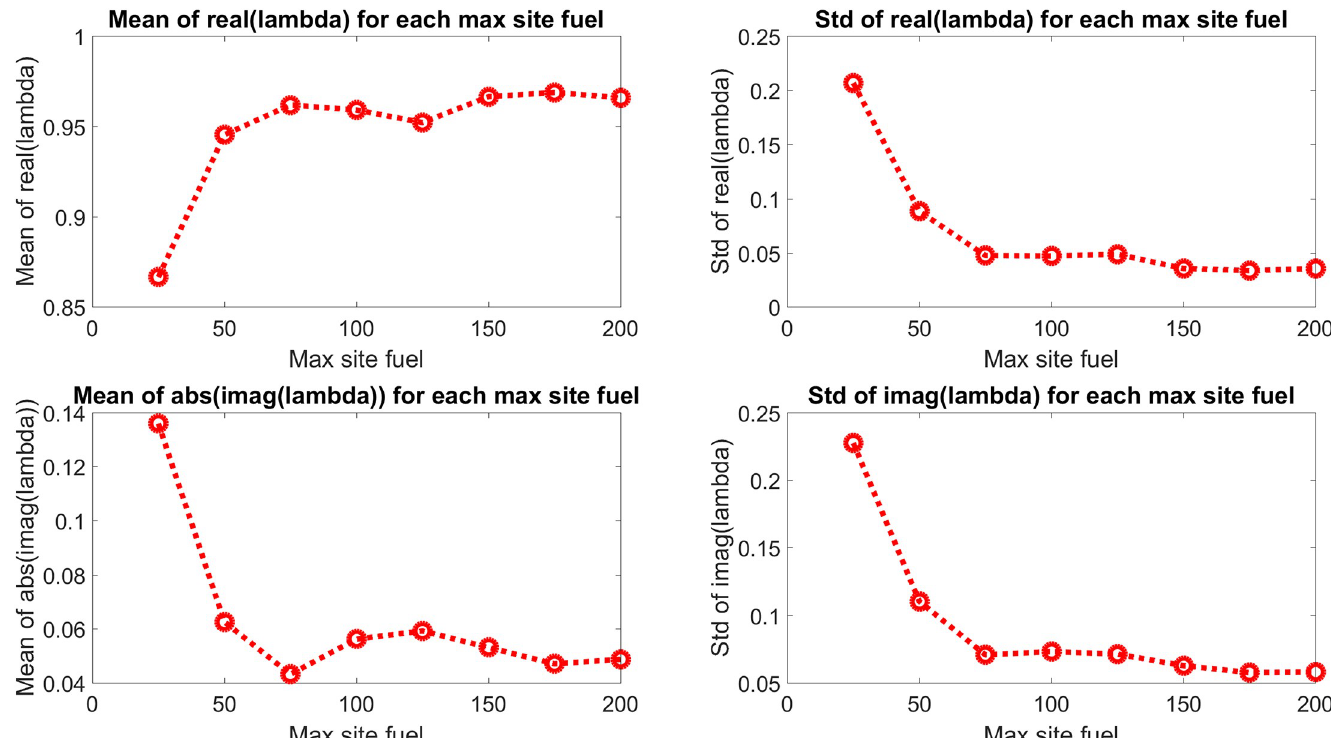
Fig 21. Mean and standard deviation of second mode eigenvalue components. The second mode eigenvalues are seen to approach the unit circle and real axis with increasing values of maximum site fuel value.